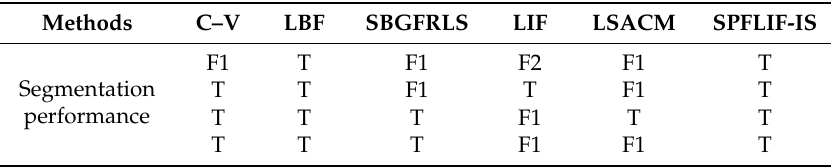
Table 1. Description of the segmentation results in Figure 2.